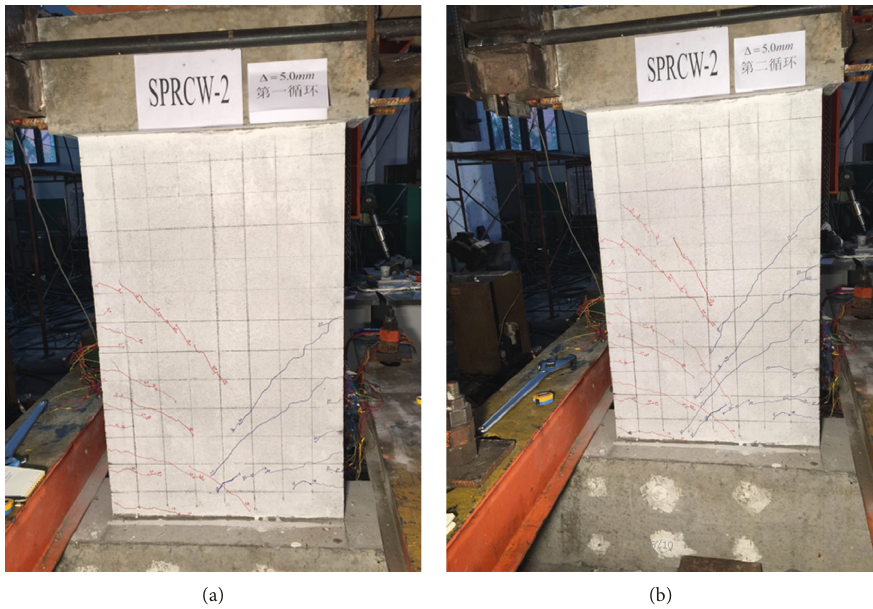
Figure 11: Diagram of cracks in the Δ � 5mm displacement cycle. (a) First cycle. (b) Second cycle.